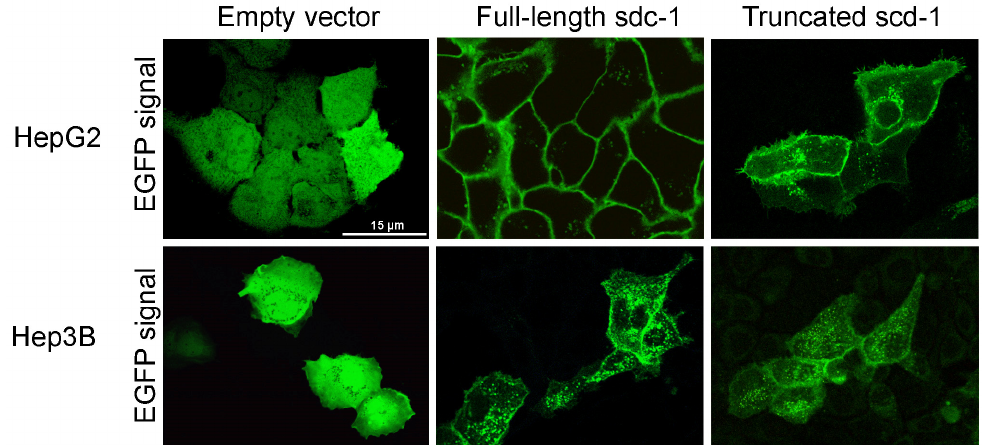
Figure 1. Immunofluorescence images of HepG2 and Hep3B cells after transfection with empty enhanced green fluorescent protein (EGFP) vector, as well as full-length and truncated syndecan-1 EGFP constructs. A diffuse green signal was seen after transfection with the empty vector. Upon transfection with the full-length syndecan-1 construct, the fluorescent signal localized to the cell membrane. Although truncated syndecan-1 partly localized to the cytoplasm, the signal was enriched at the plasma membrane, indicating that truncated syndecan-1, lacking the extracellular domain, was sorted successfully. Representative images are at 1000× magnification (scale bar 15 μ m).